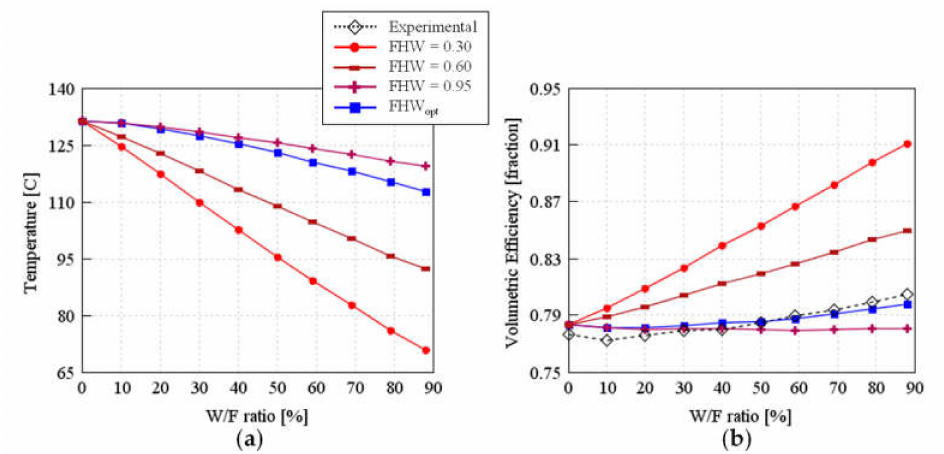
Figure 10. ( a ) In-cylinder temperature measured at Intake Valve Closing (IVC) and ( b ) Volumetric E ffi ciency as a function of the Water-to-Fuel ratio for di ff erent values of the Fraction of Vaporized Heat Taken from Walls (FHW) model calibration parameter; operating point 2500 rpm–18